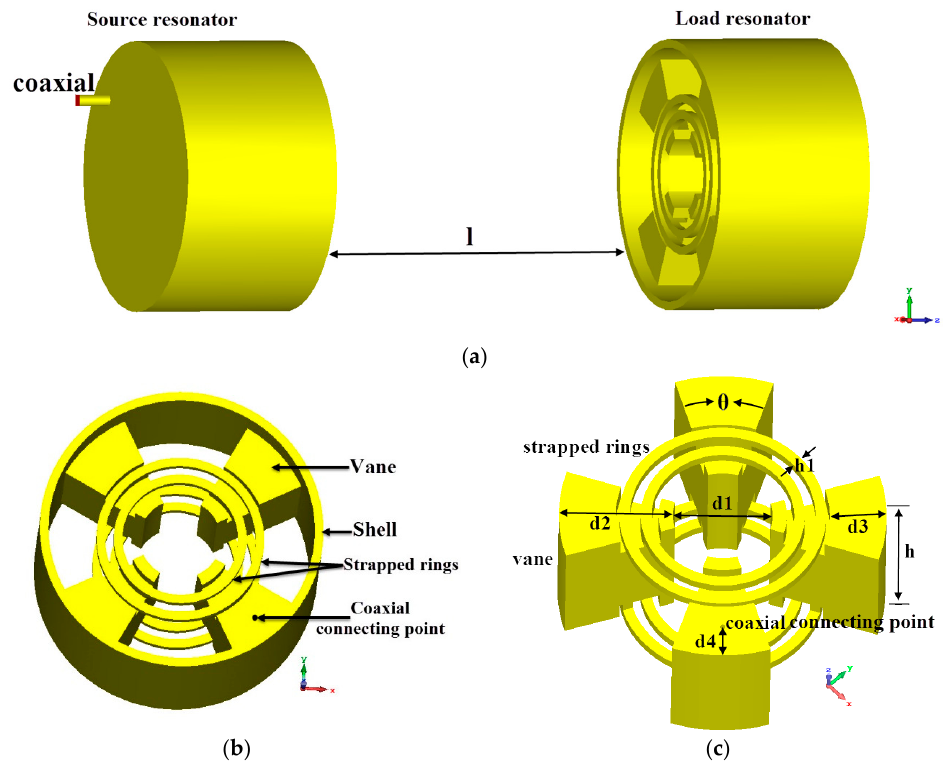
Figure 1. Wireless power transfer (WPT) system based on strapped resonator (SR): ( a ) Coupling model, ( b ) structure of strapped resonator, and ( c ) details of the strapped